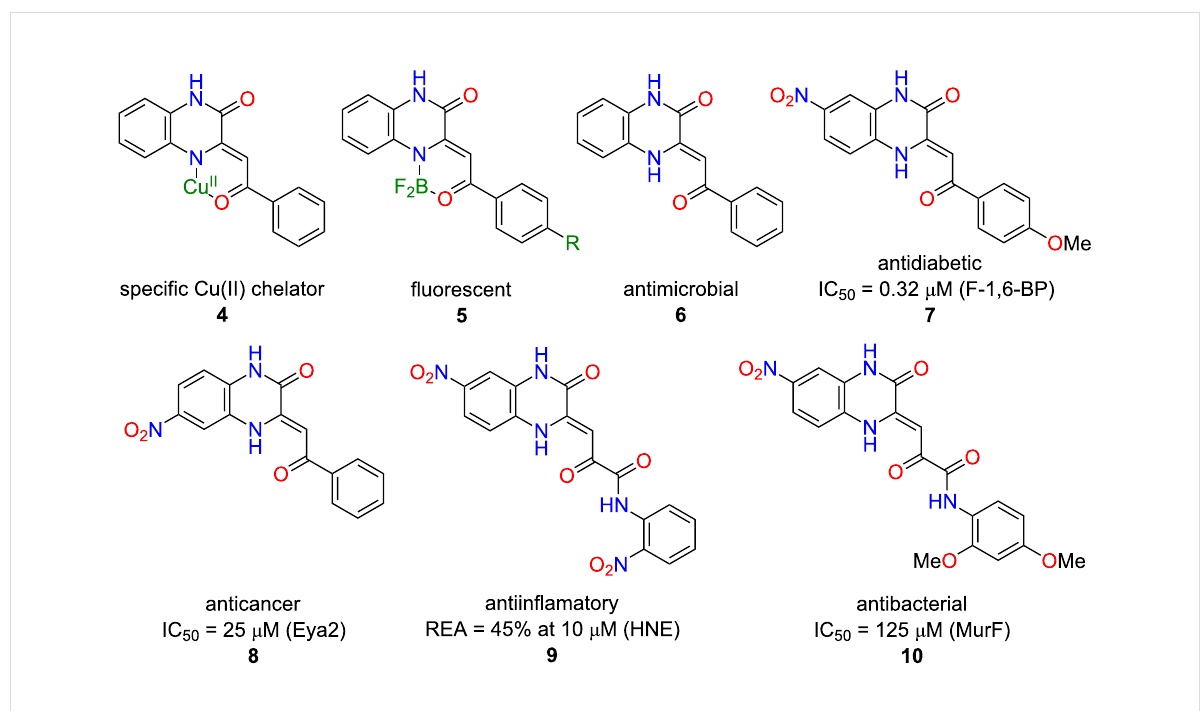
Figure 1: The structures including some of their physical and biological properties of 3,4-dihydroqunoxalin-2(1 H )-ones 4–10 . Abbreviations used: F-1,6-BP = fructose 1,6-bisphosphatase; Eya2 = eyes absent homolog 2; HNE = human neutrophil elastase; MurF = muramyl ligase F; REA = remaining